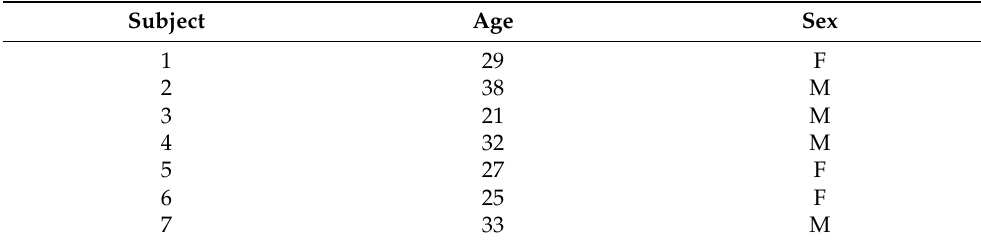
Table 1. Patient epidemiological